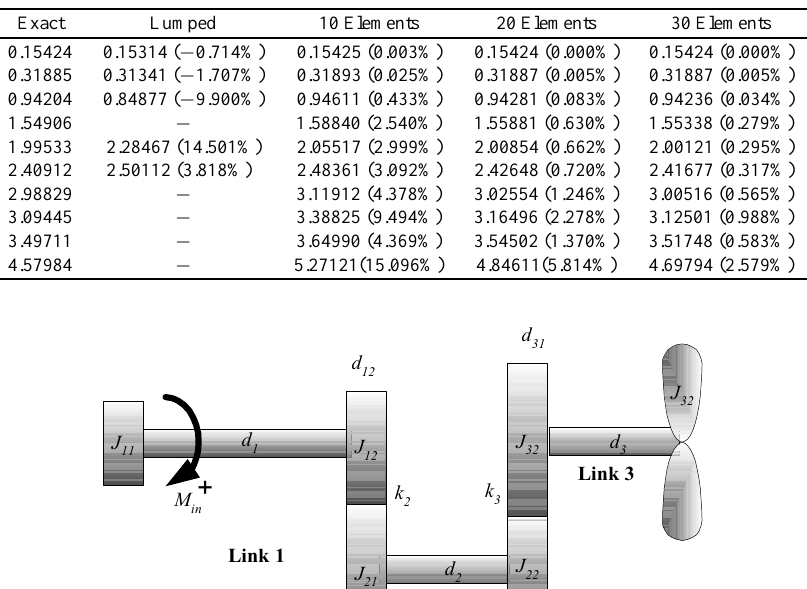
Table 3 Natural frequencies and approximation errors for longer shafts (kHz)